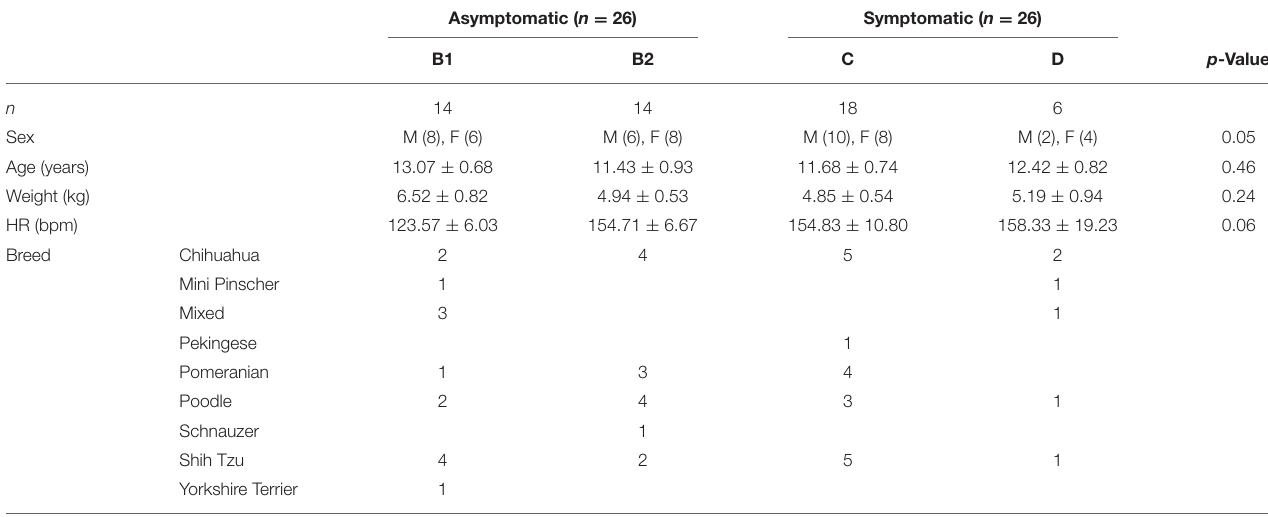
TABLE 1 | Description of dogs in different stages of MMVD in this study. Asymptomatic ( n = 26) Symptomatic ( n =